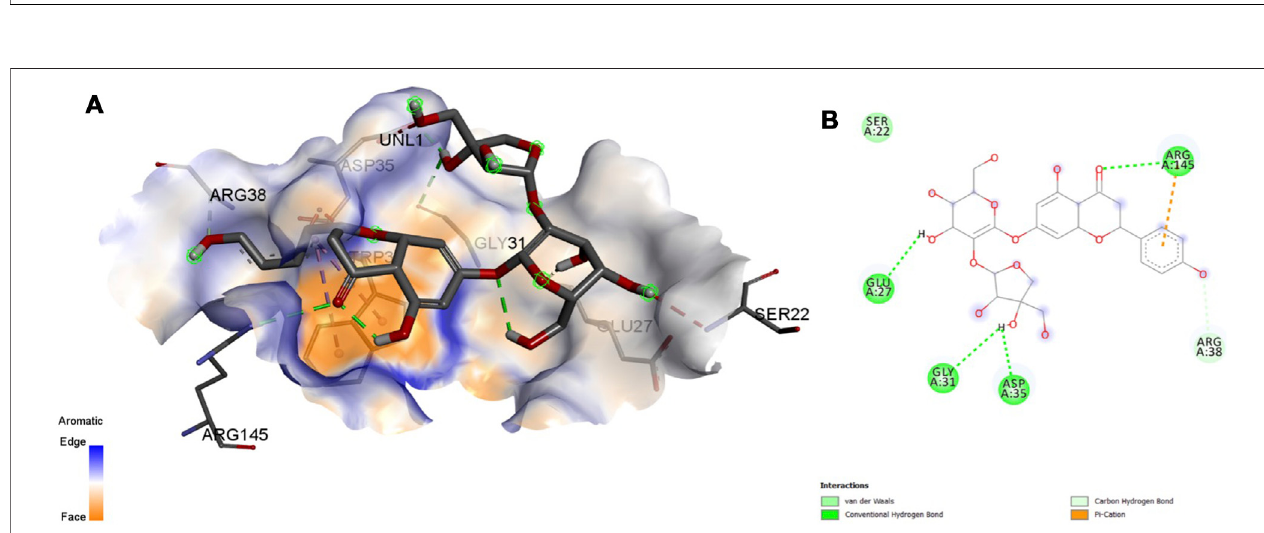
FIGURE 8 | Molecular docking interaction analysis of protein 1GS9, (A) : 3D interactions and (B) : 2D interactions have been represented between 1GS9-Apiin complex structures.